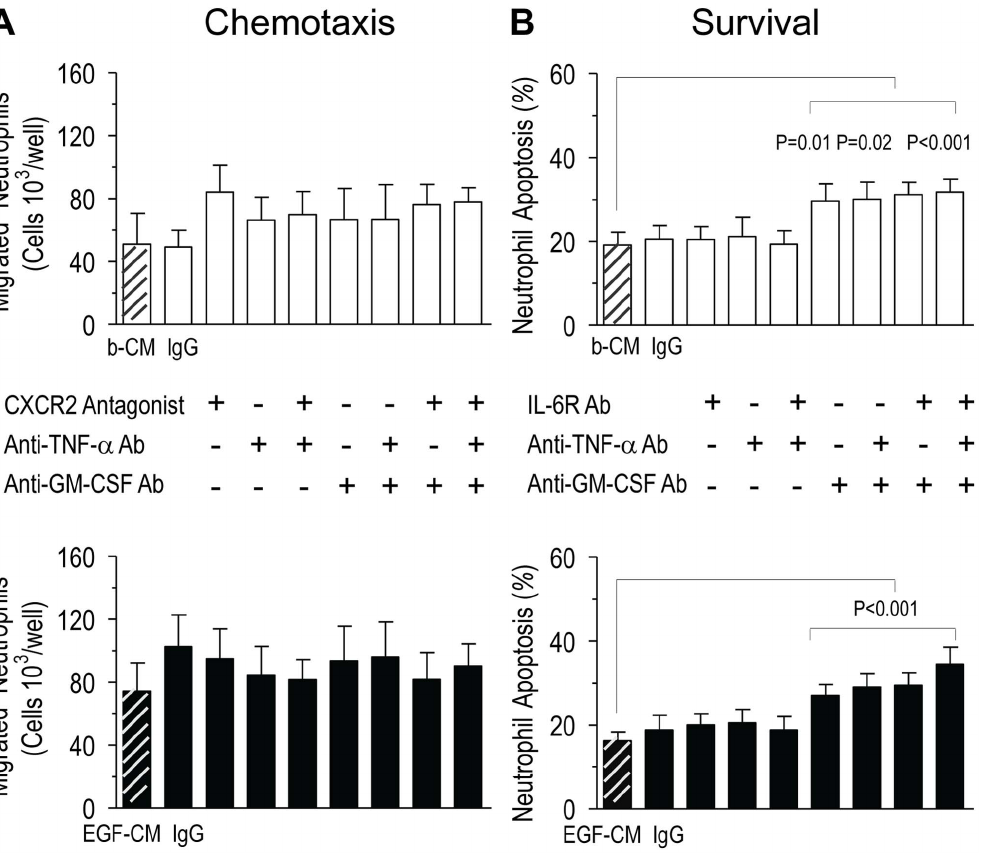
Figure 4. Characterization of neutrophil chemotactic and anti-apoptotic activity in PBEC-CM from Mod/Sev asthmatics. A) Neutralizing monoclonal antibodies (mAb) against TNF- a or GM-CSF (100 m g/ml or their isotype-matched IgG controls) and the CXCR2 antagonist, SB- 225002 (100 nM) did not affect basal-CM ( open bars ) or EGF-CM- ( solid bars ) mediated neutrophil migration ( n =8 donors). (B) In neutrophil apoptosis studies, neutralization of GM-CSF activity alone or in combination with TNF- a or IL-6R blockade inhibited basal-CM and EGF-CM-induced survival ( n =7 donors). Data represent mean 6 SEM analysed using repeated one-way ANOVA with post-hoc Bonferroni correction.